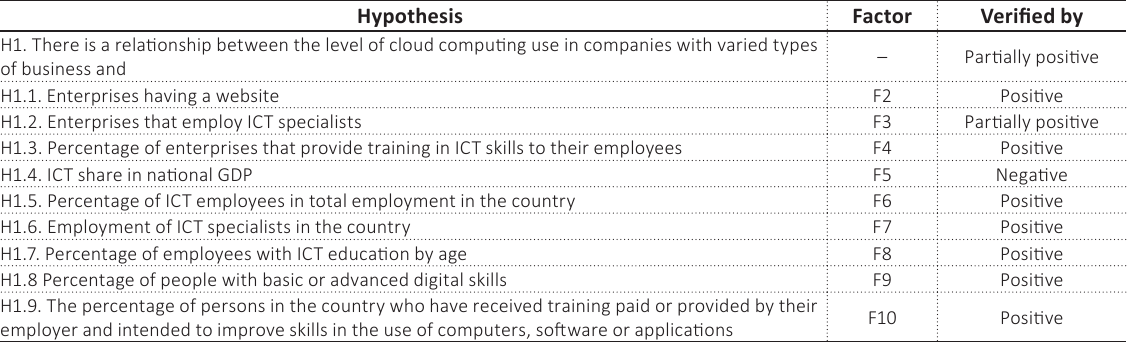
Table 5. Verification of research